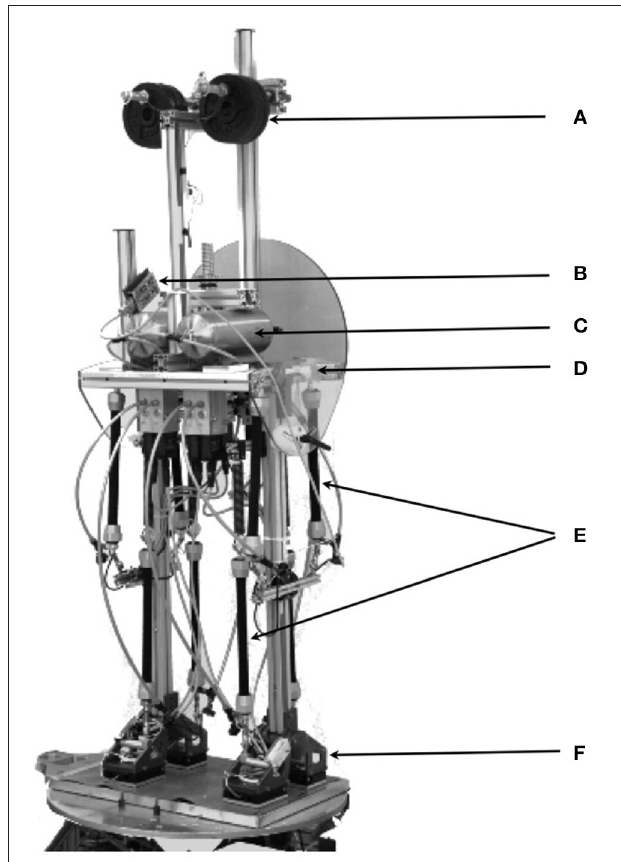
FIGURE 1 | Postural humanoid robot PostuRob II standing freely on a 6 DOFs motion platform. (A) weights for human-like weight distribution; (B), artificial vestibular system; (C), pneumatic system; (D), hip joint (joint angle and torque sensors); (E), artificial pneumatic “muscles”; (F), ankle joint (joint angle